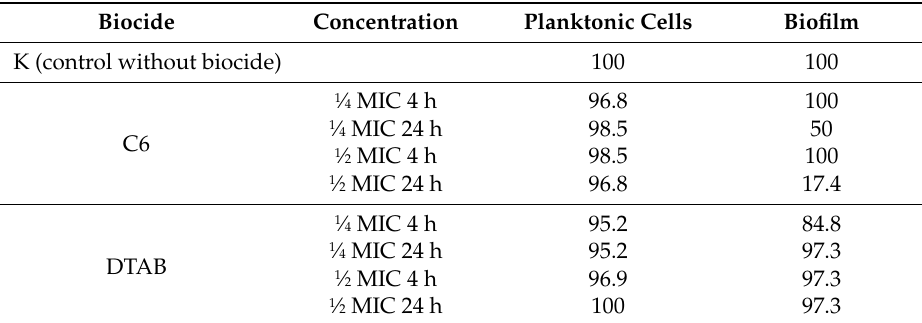
Table 1. Similarity of proteins profiles of P. aeruginosa PB_1 after monomeric DATB and gemini surfactant C6 treatment.